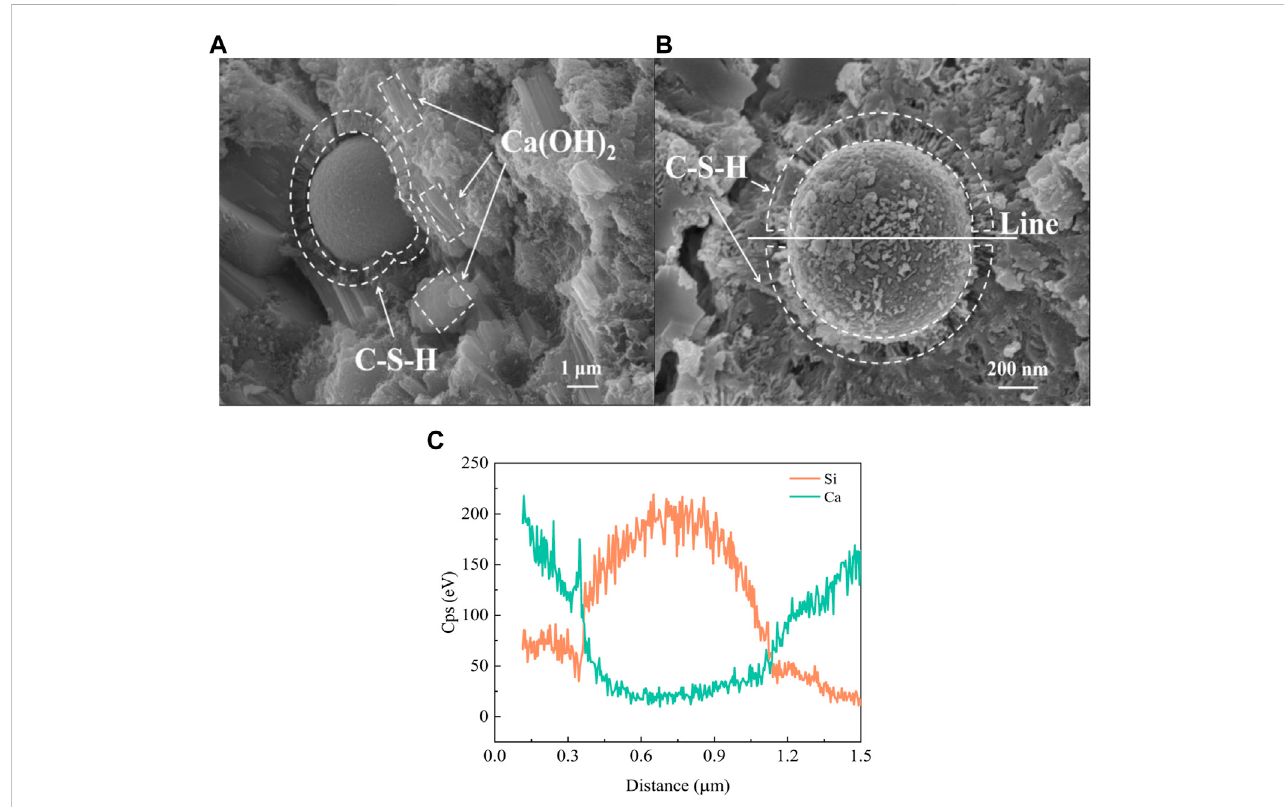
FIGURE 7 Spherical vitreous morphology of FA in LHCC under (A) 20,000x and (B) 50,000x (C) element line scanning in (B) .